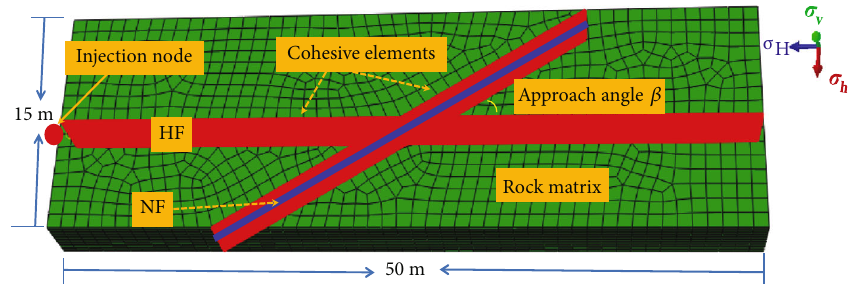
Figure 6: Schematic diagrams of the intersection of an extending hydrofracture with a preexisting natural fracture in a 3D domain, where hydrofracture is along the orientation of maximum far fi eld stress σ approaching angle is denoted as β .